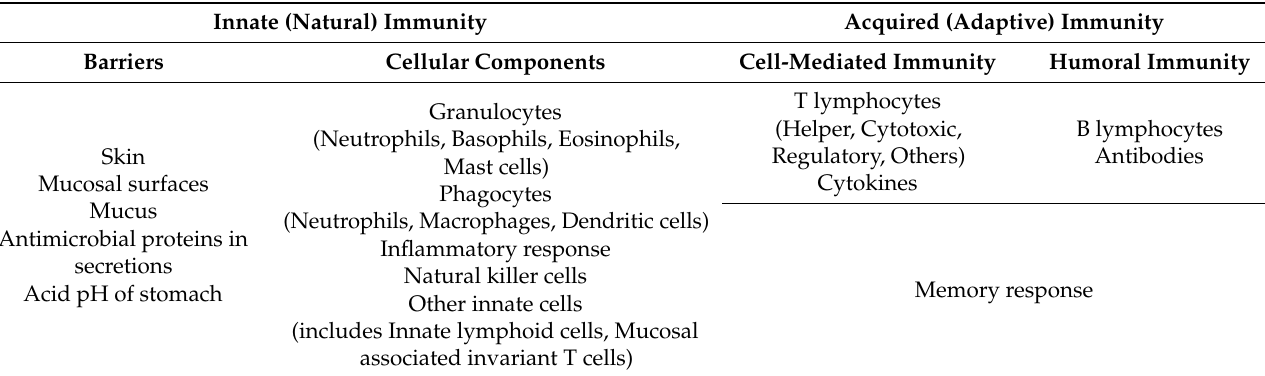
Table 1. Overview of the components of the immune system and their classification into innate and acquired immunity. Innate (Natural)